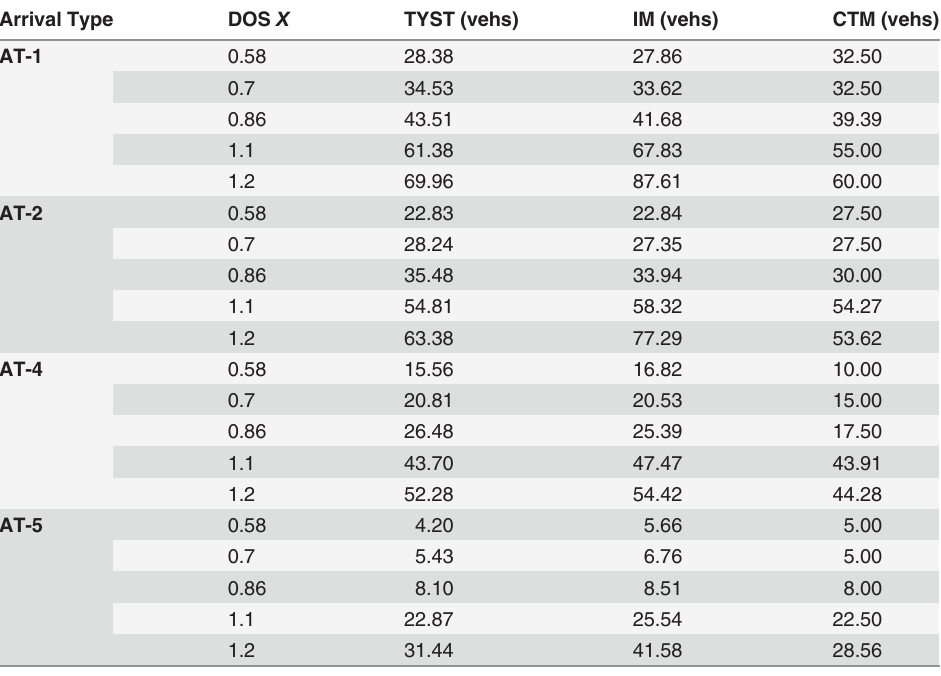
Table 4. Comparison of maximum end of red queues Q MEOR (T = 15